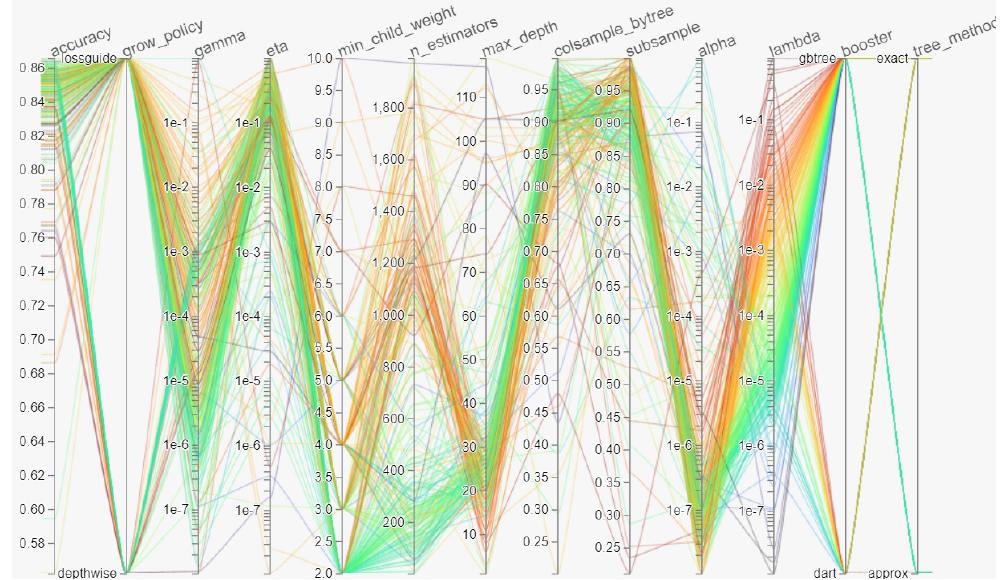
Figure 6. Visualisation of the hyperparameter optimisation procedure for the XGB algorithm. Note that notation Ae-B is meant to represent A × 10 − B in scientific notation. Table 1. Hyperparameters for base learners and bagging ensembles.